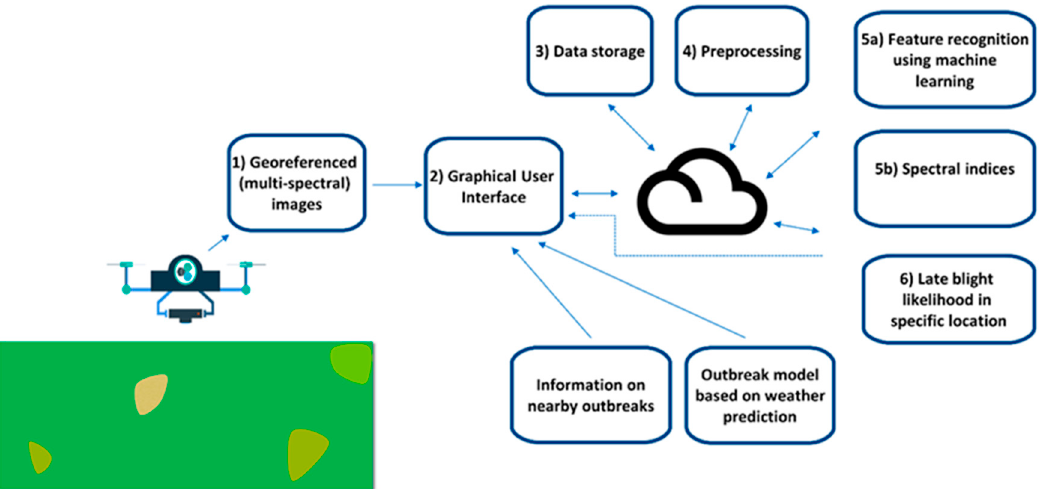
Figure 2. Schematic components of an app to detect early outbreaks of diseases in the field, which through cloud-computing integrates high-throughput phenotyping, storage, analysis by, for example, machine learning, meteorological and economic data. Numbers indicate the procession of the required workflow.